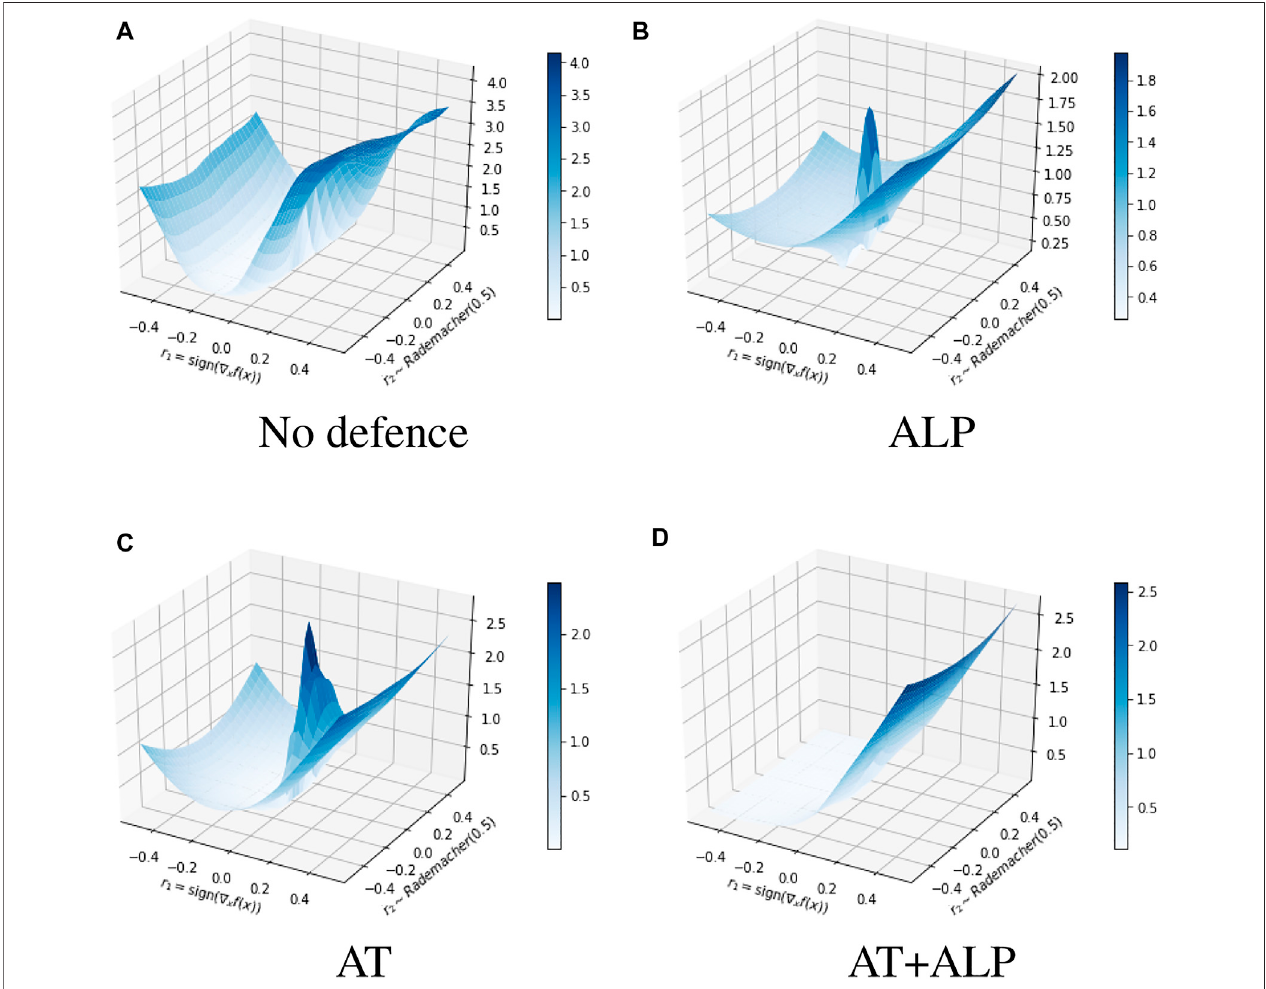
FIGURE 6 | Comparison of loss landscapes generated by No defence (A) , ALP (B) , AT (C) and AT+ALP (D) . We see that ALP and AT sometimes induces decreasedlossneartheinputlocally,andgivesa “ bumpier ” optimizationlandscape,our AT + ALP hasbetterrobustness.The z axisrepresentstheloss.If x istheoriginal input,thenweplotthelossvaryingalongthespacedeterminedbytwovectors: r 1 (cid:1) sign ( ▽ x f ( x )) and r 2 ∼ Rademacher (0.5).Wethusplotthefollowingfunction: z (cid:1) loss ( x · r 1 + y · r